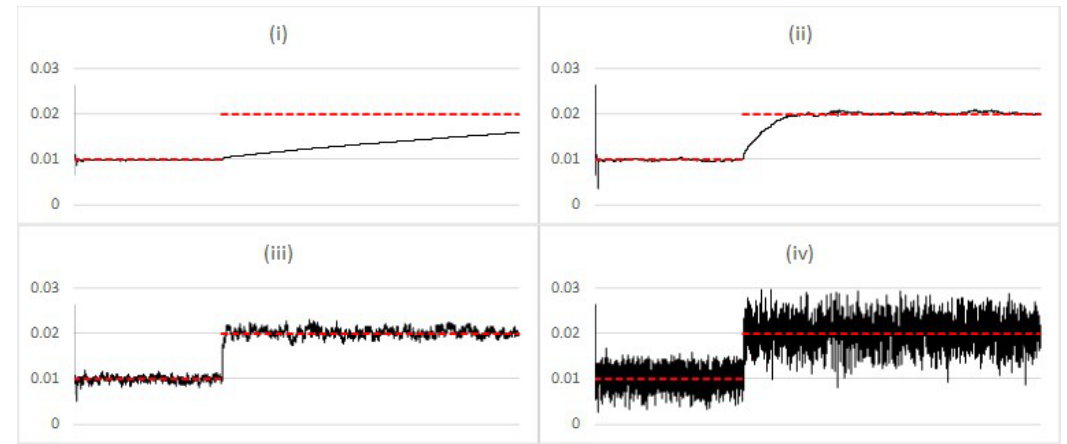
Figure 2. Comparing estimated posterior expected value (black) vs. simulation input value (red) of σ t , when there is a regime change after 10,000 steps, using the Liu and West filter with additional noise, for different values of φ ( i ) 0.1 ( iii ) 10.0 ; ( iv ) 100.0 N N